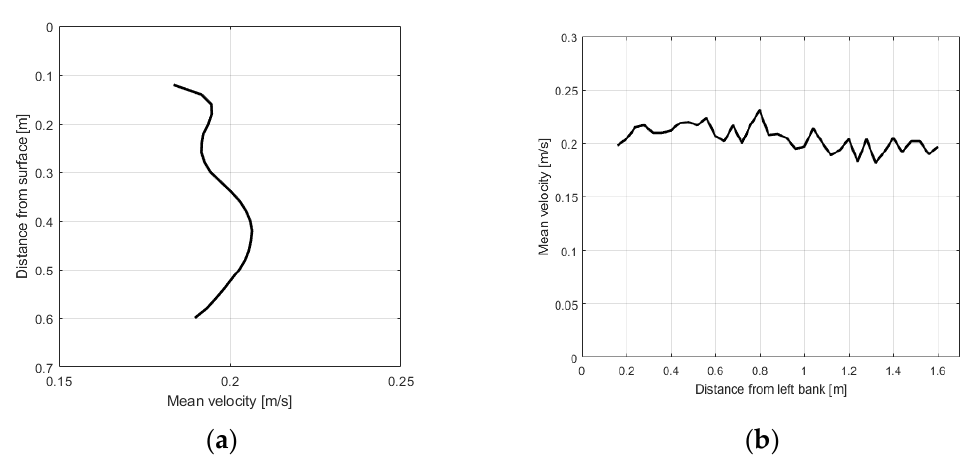
Figure 14. ( a ) Vertical flow velocity distribution and ( b ) horizontal flow velocity distribution.